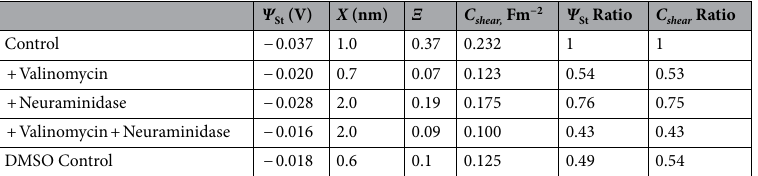
Table 1. Estimated electrical properties for RBCs. The estimated values of surface potential Ψ St and shear plane thickness from the best fit curves shown in Figs. 2 and 5 after adjusting ζ by an amount Ξ multipled by the measured V m . When the capacitance between shear plane and membrane C shear was calculated, the Ψ St ratios and C shear ratios show a high degree of similarity.